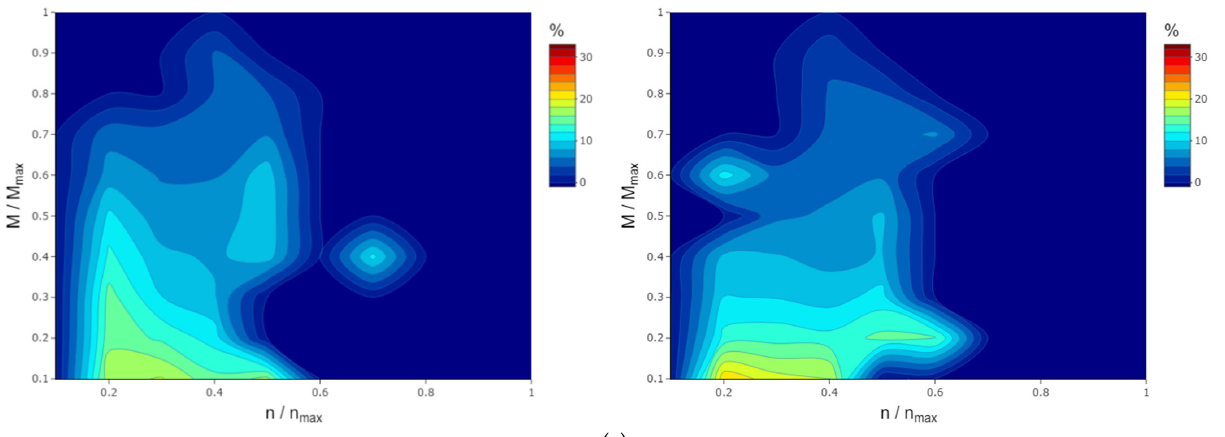
Figure 6. Distribution maps of average percentage fuel consumption reduction factor for a case of optimal gear selection during driving on different roads for Vehicle 1 (on the right side) and Vehicle 2 (on the left side) ( a ) city roads, ( b ) rural roads, ( c ) motorways.